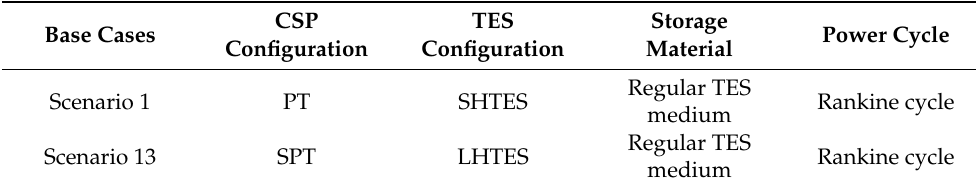
Table 7. Definition of base